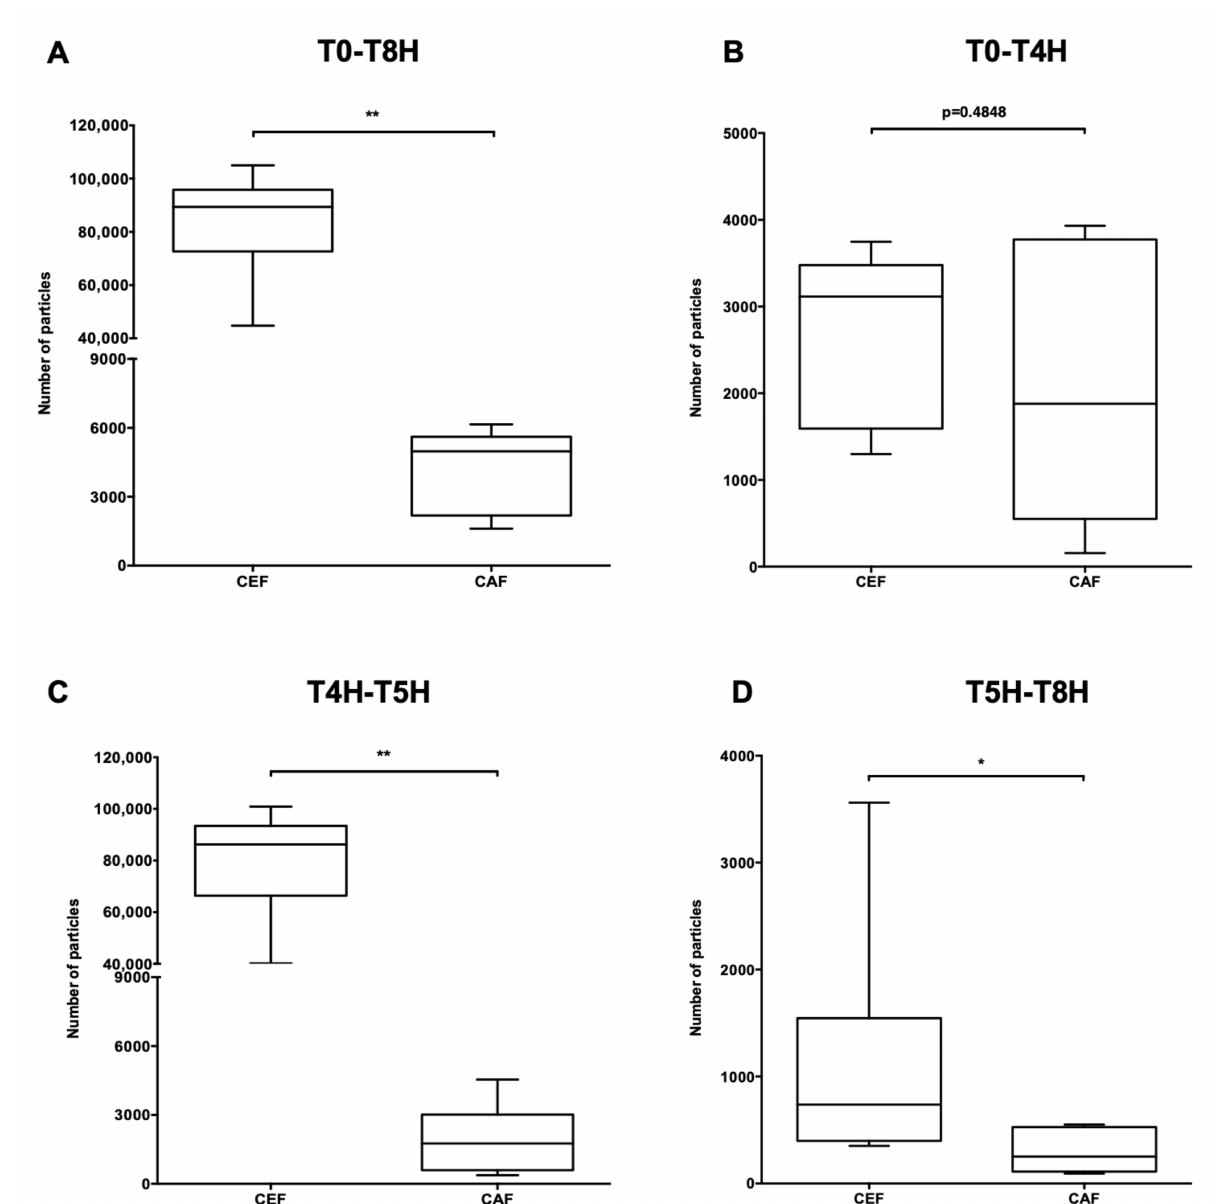
Figure 6. Impact of the choice of infusion line on particulate load. Comparison of total particulate load as a function of infusion line at times T0-T8H ( A ); T0-T4H ( B ); T4H-T5H ( C ); T5H-T8H ( D ). Results are expressed as medians [min; max] (**: p < 0.01, *: p < 0.05, Mann Whitney, p < 0.05, n =